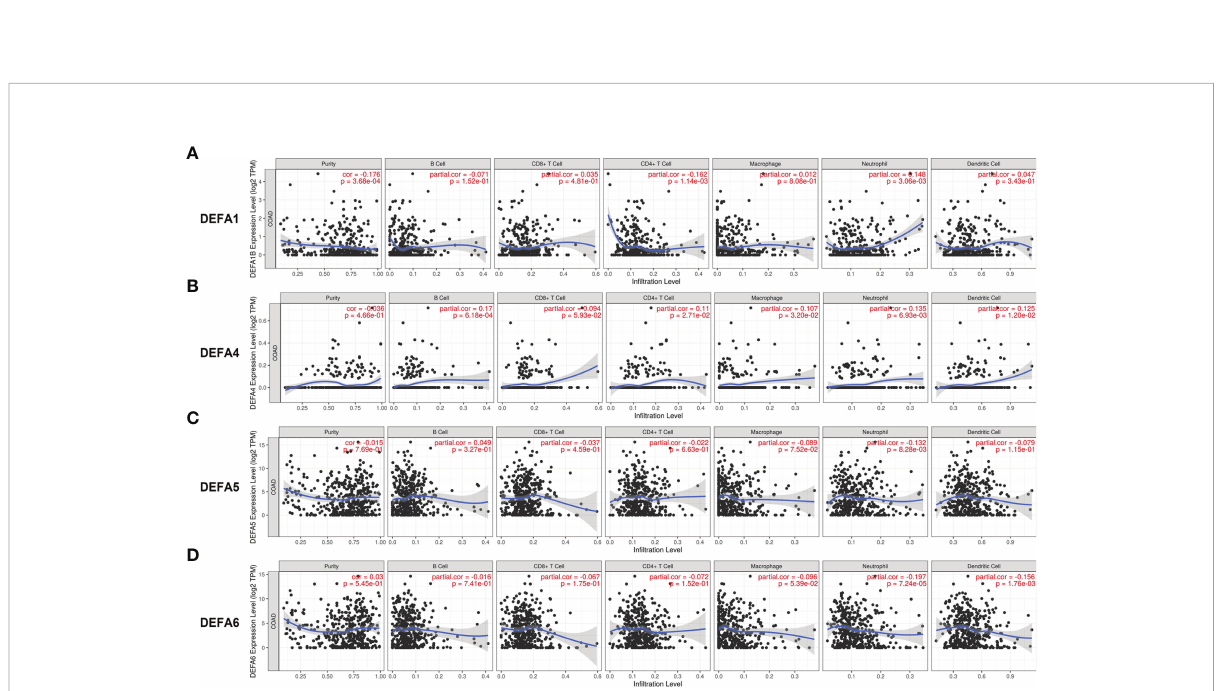
FIGURE 10 Immune in fi ltration of DEFAs in CRC. (A) Immune in fi ltration of DEFA1 in CRC; (B) Immune in fi ltration of DEFA4 in CRC; (C) Immune in fi ltration of DEFA5 in CRC; (D) Immune in fi ltration of DEFA6 in